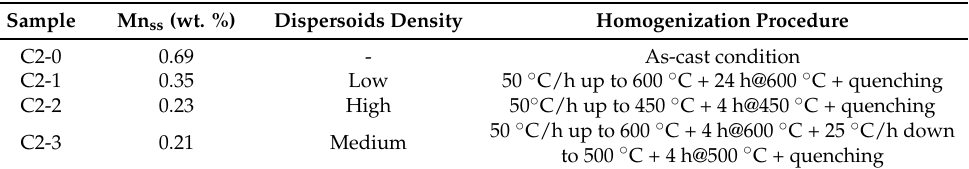
Table 1. Four homogenization procedures and resulting different concentration levels of Mn in solid